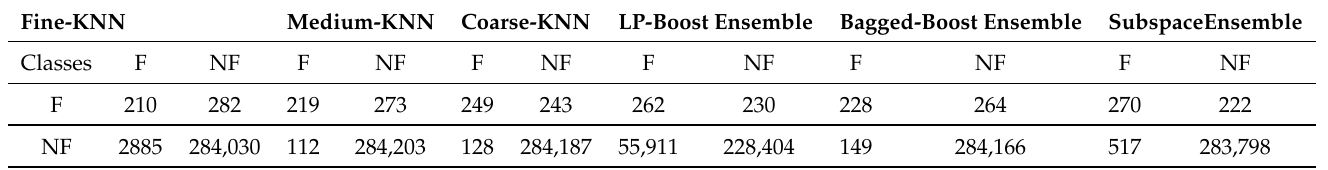
Table 6. Confusion matrix of 5-fold classification methods on transformed